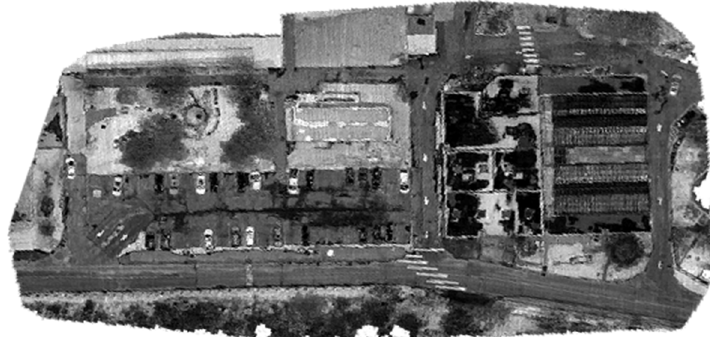
Figure 12. Intensity raster generated using the LiDAR data point cloud for the first test site.